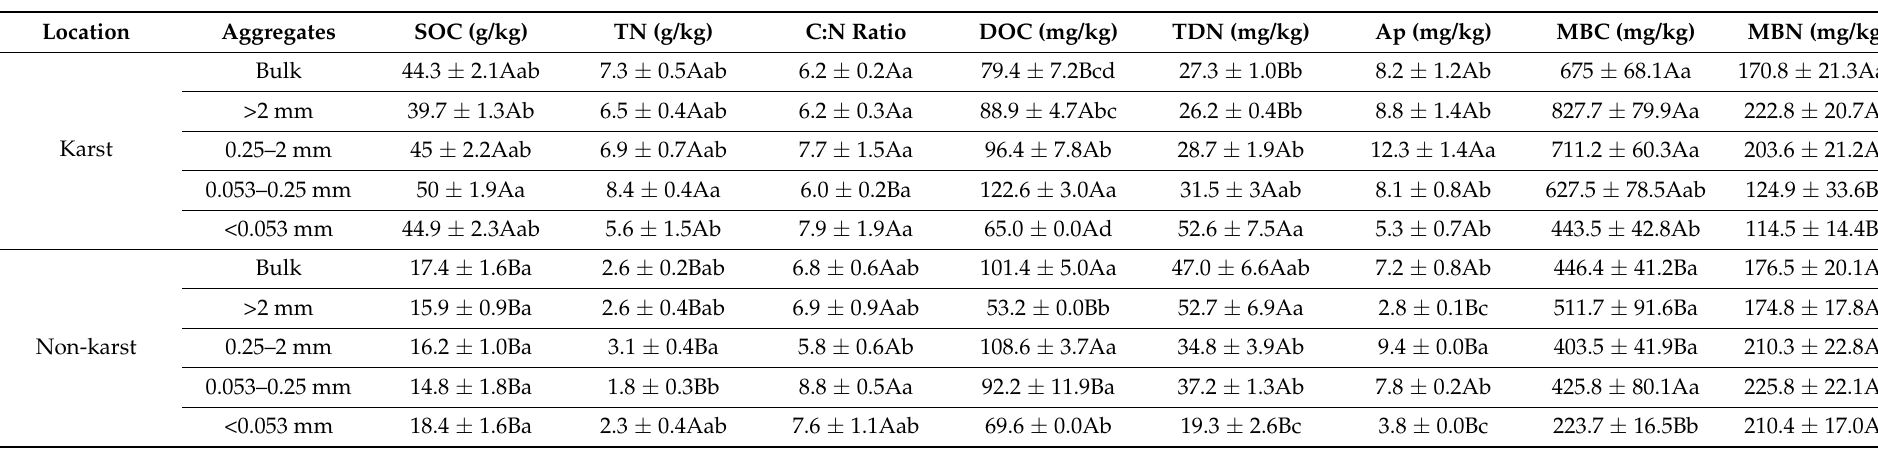
Table 1. Differential soil properties between karst and non-karst forests in Guangxi, Southwest China. Values are the M ±